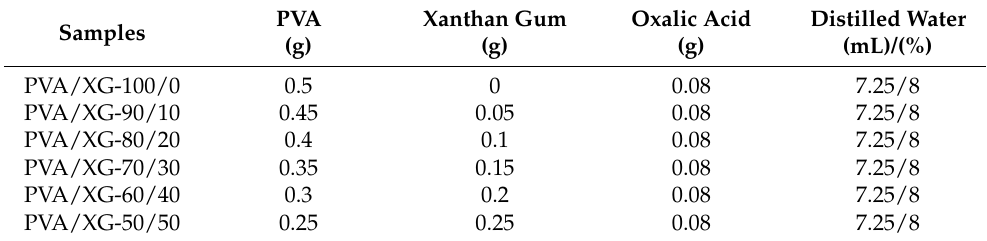
Table 1. The composition of PVA/XG